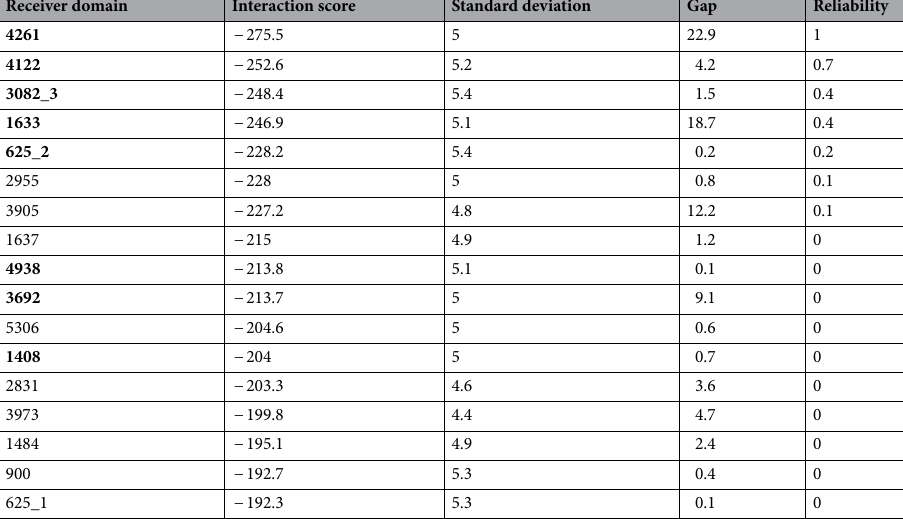
Table 1. Direct coupling analysis. The results show the interaction scores (effective interaction energies) with the kinase domain of GacS. All the receiver domains involved in P. brassicacearum hybrid HKs were considered, and ranked from smallest to largest interaction scores. The gap corresponds to the difference in interaction score between two successive ranks. The reliability score represents the fraction of bootstrapping replicates where the ranking down to this domain remained identical to the one obtained without bootstrapping (see “Materials and Methods”). The receiver domains belonging to the GacS cluster are marked in bold.